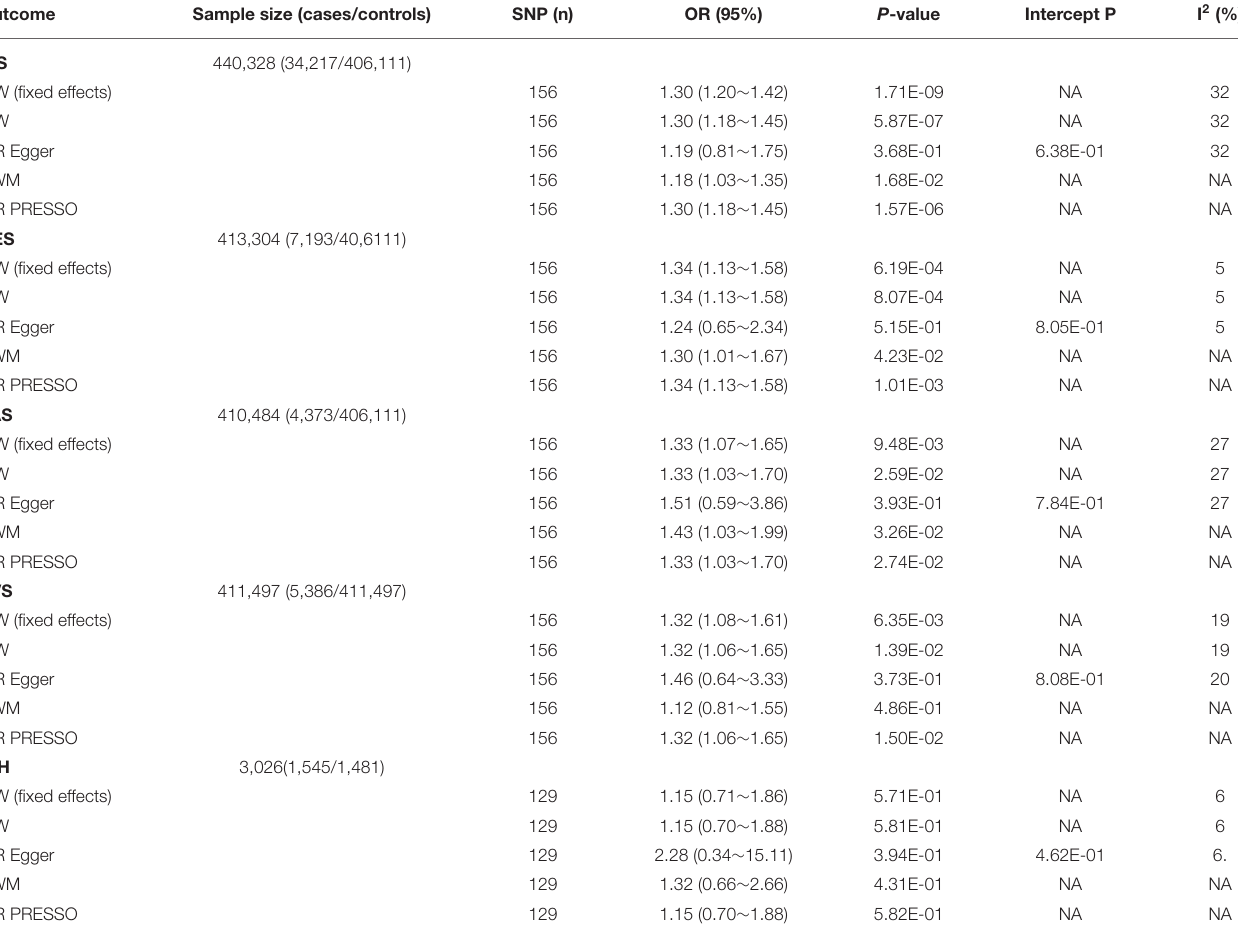
TABLE 1 | Casual relationships between VAT and stroke. Outcome Sample size (cases/controls) SNP (n) OR